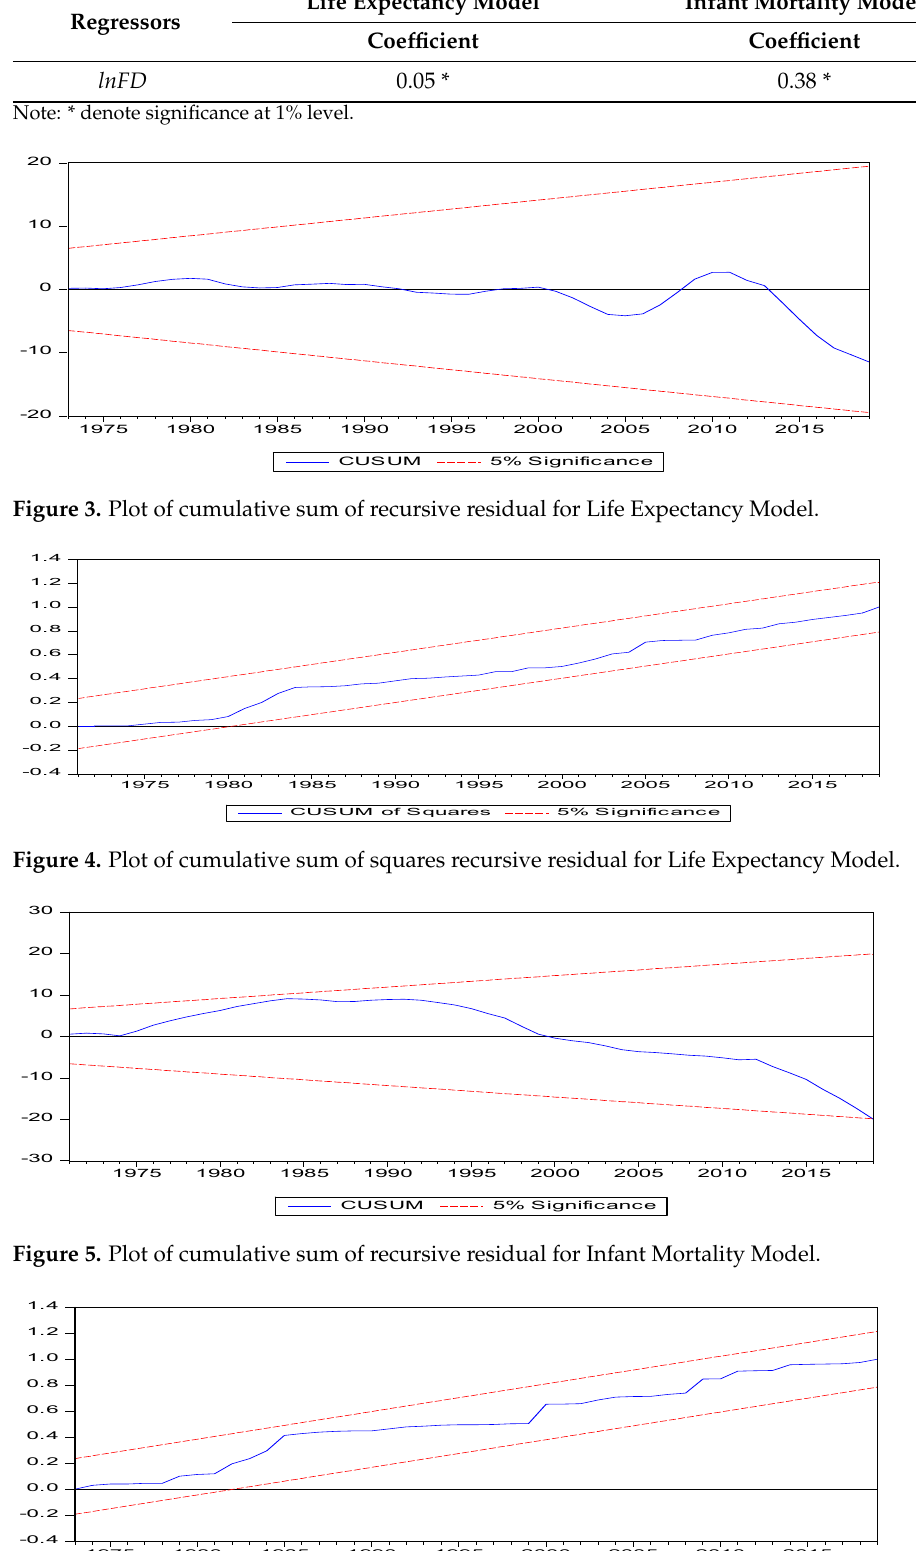
-0.4-0.20.0 Figure 6. Plot of cumulative sum of squares recursive residual. Figure 6. Plot of cumulative sum of squares recursive residual. Figure 6. Plot of cumulative sum of squares recursive residual. Figure 6. Plot of cumulative sum of squares recursive